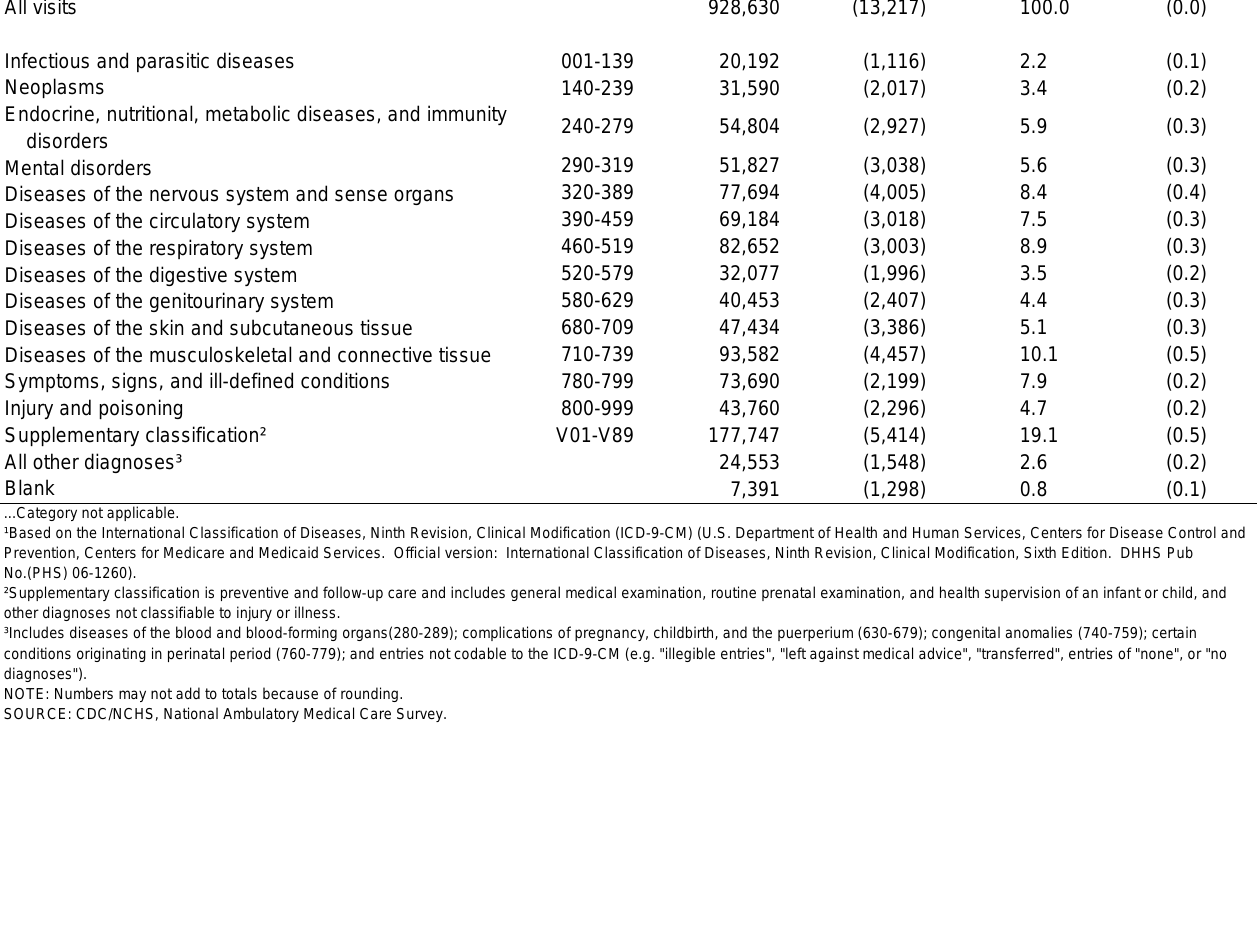
Infectious and parasitic diseases Neoplasms Endocrine, nutritional, metabolic diseases, and immunity